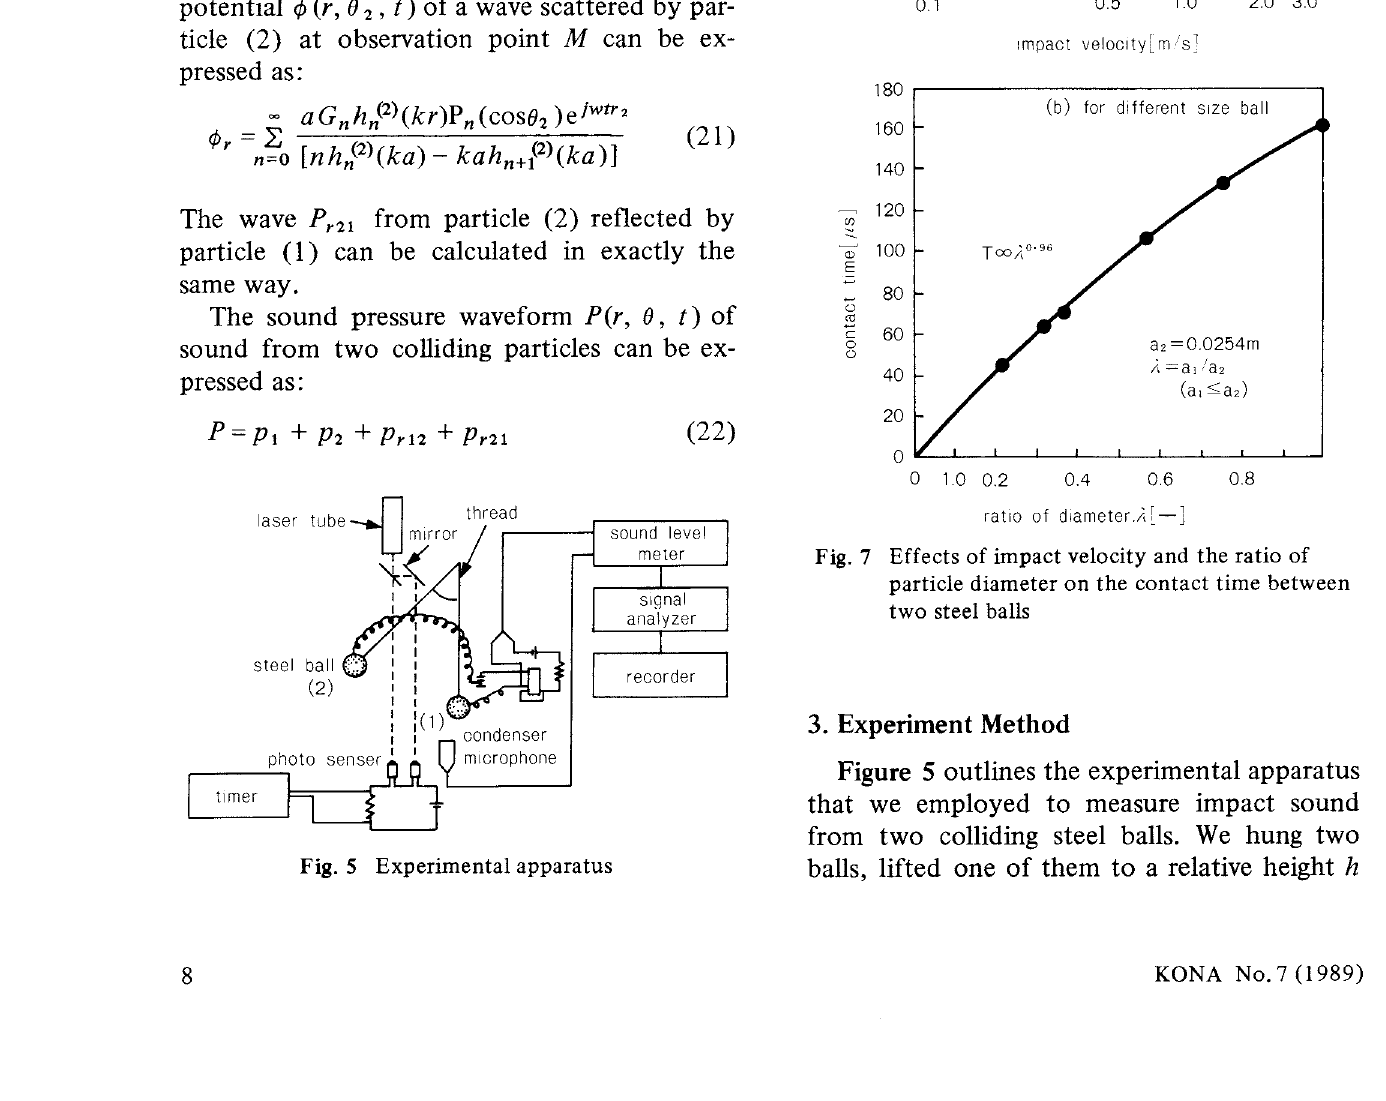
Fig. 6 Waveforms of acceleration for collision of two steel balls